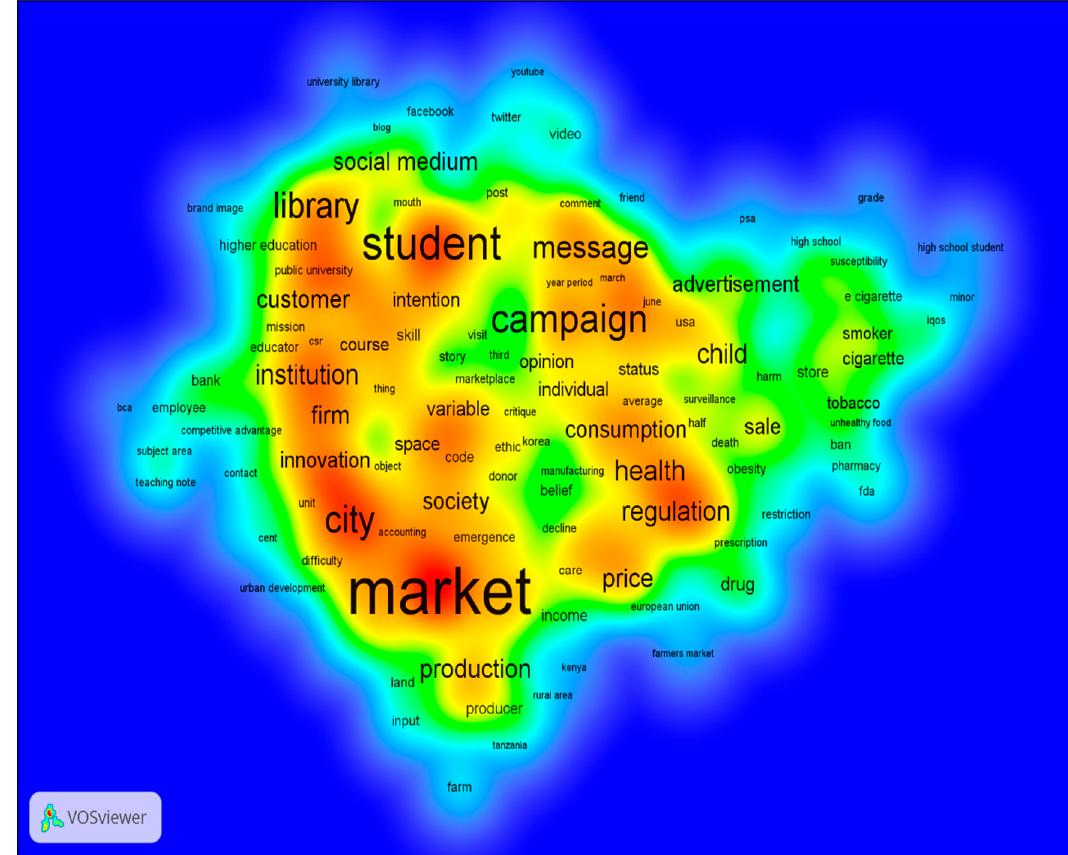
Figure 11. Density map (1980–2020). Source: authors using VOSviewer software.